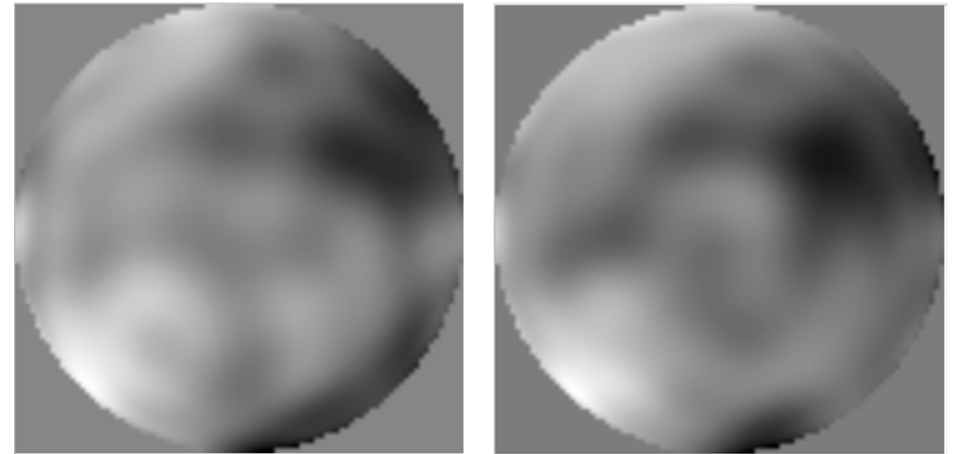
Figure 2. Comparison of a sample of the first test set. The residual WFE for this case is 160.85 nm, higher than the mean value obtained over the test. The original phase is placed on the left, with the reconstructed one shown on the right.